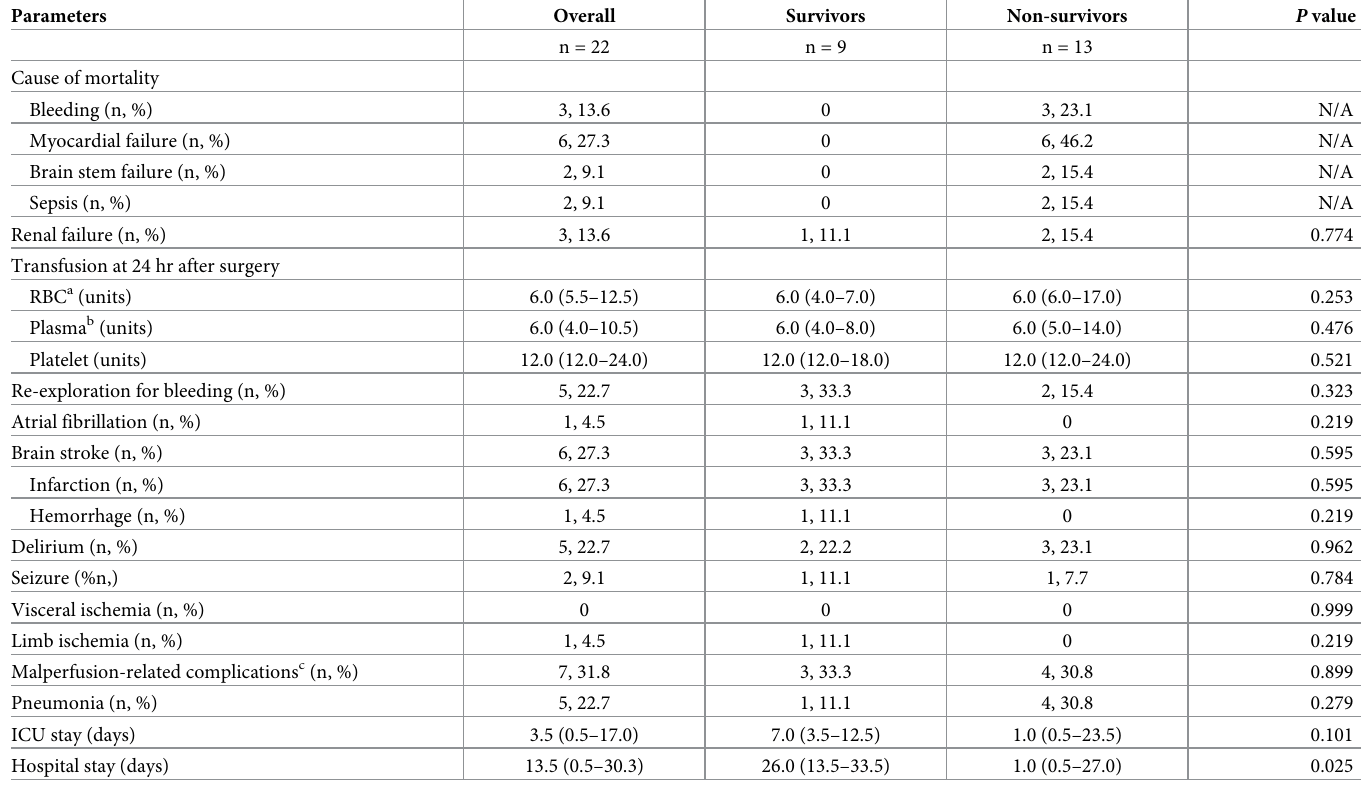
Table 4. Postoperative mortality and morbidity according to patient group.